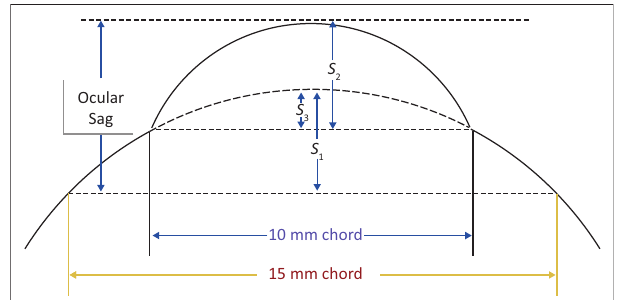
FIGURE 1: Schematic representing the total ocular sag of an eye based on a 15-mm scleral chord and a 10-mm corneal chord S sags as discussed in the